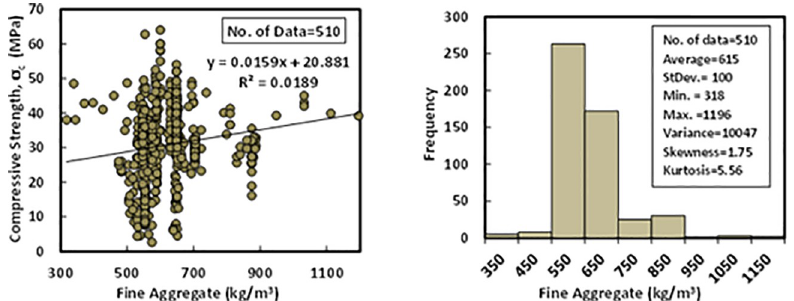
Fig 5. Variation between compressive strength and fine aggregate content with the histogram of fly ash-based geopolymer concrete mixtures.